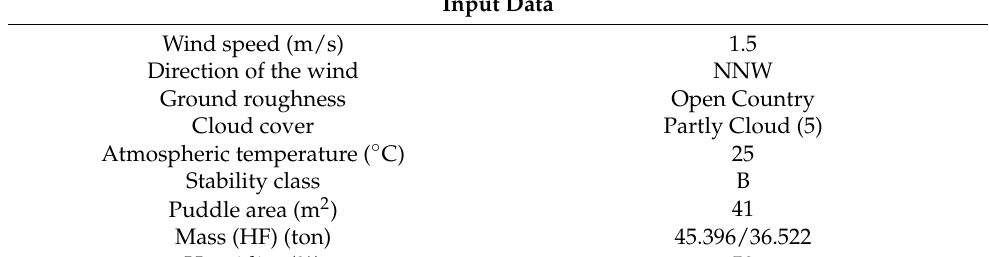
Table 2. Input data for the simulation of ALOHA.